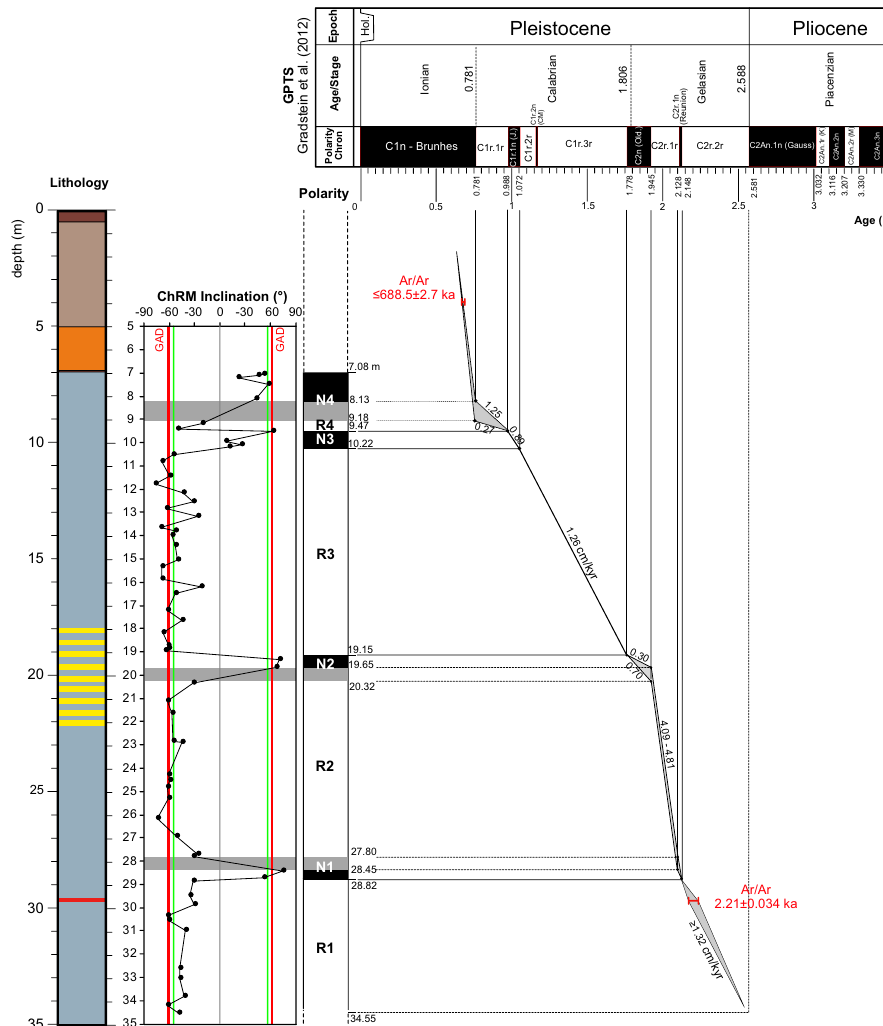
Figure 8. Correlation of the new magnetic polarity zonation from CM1 with the GPTS of 46